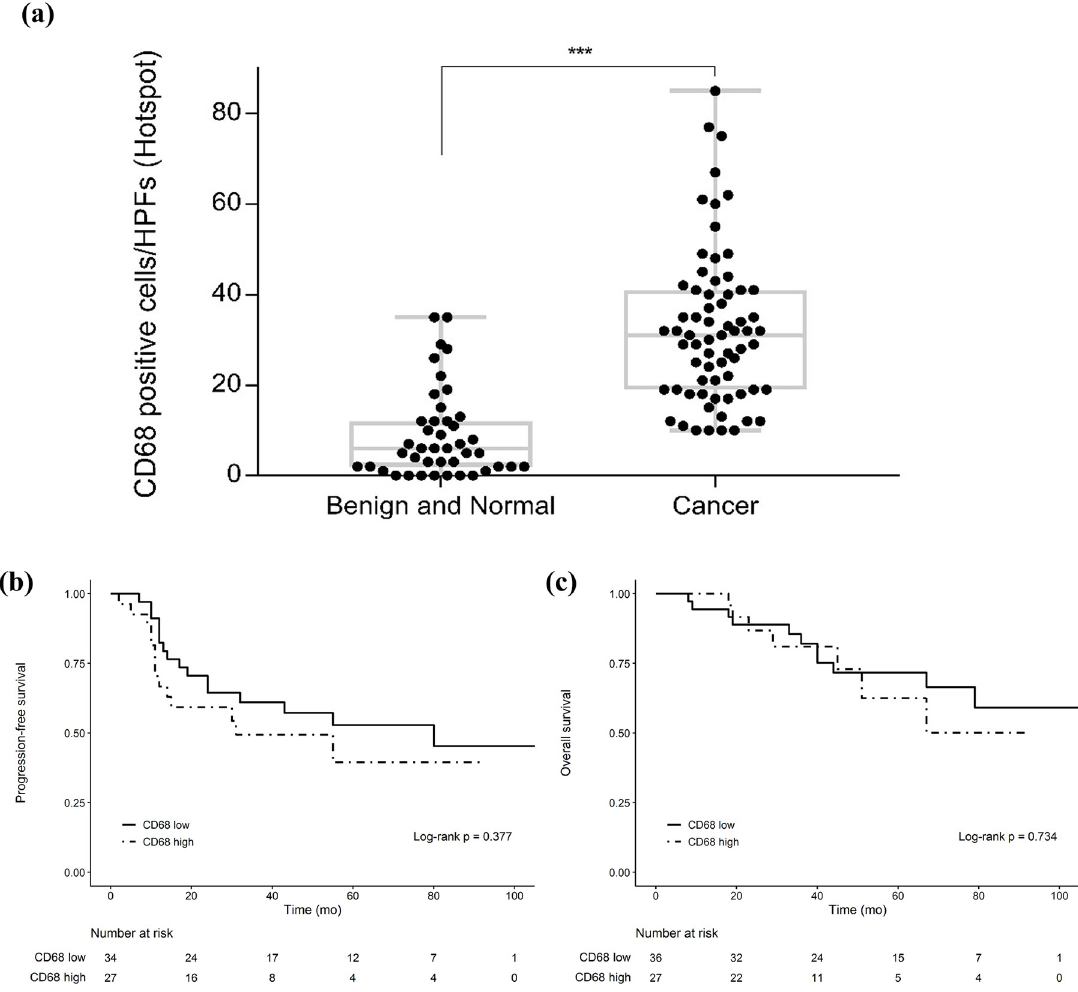
Fig 6. Difference in CD68 expression between normal or benign ovarian tissues and ovarian cancer tissues and survival analysis of patients with low and high CD68 expression. (a) CD68-positive cells in normal, benign, and cancer ovarian cells. � p < 0.05, �� p < 0.01, ��� p < 0.001. Analysis of (b) OS and (c) PFS based on CD68